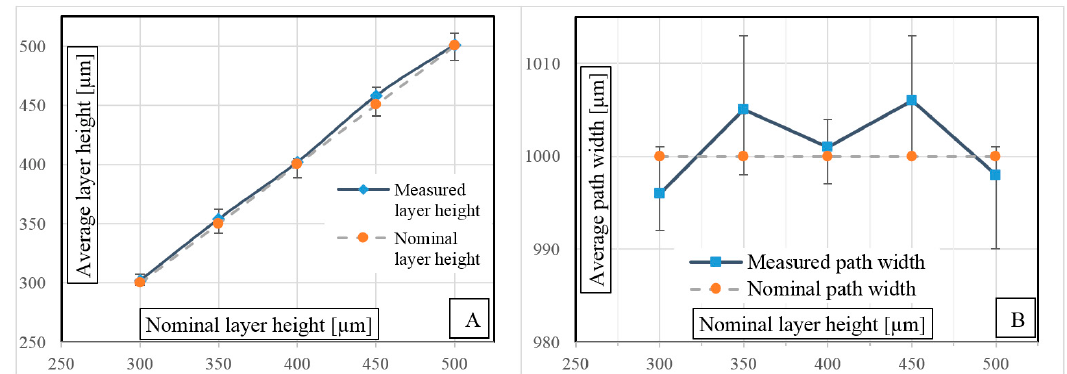
Figure 7. Comparison of measured and nominal ( A ) composite print layer heights and ( B ) single path widths.